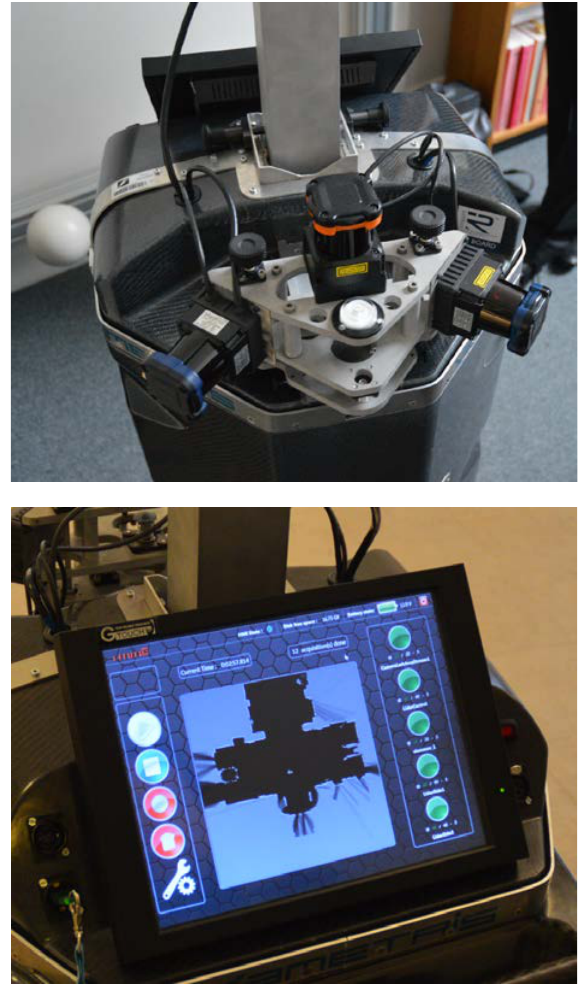
Figure 1: i-MMS scanner array (top) and control screen showing SLAM result (bottom).